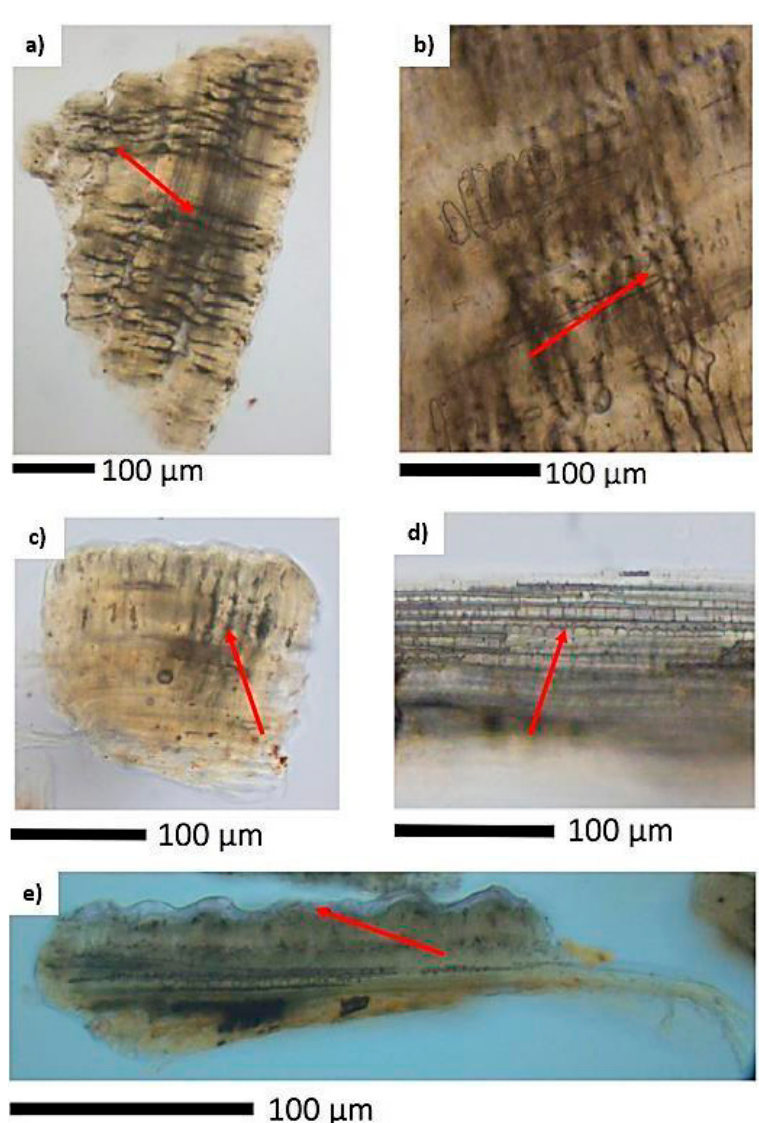
Figure 3. Bright field light microscopy images highlighting the tubular structure of tracheids (red arrows): ( a , b ) Milled rice husk (RH) with average size of 200–400 µm; ( c , d ) milled RH with average size of 100–200 µm; ( e ) detail of the external siliceous layer of a fragment of milled RH.